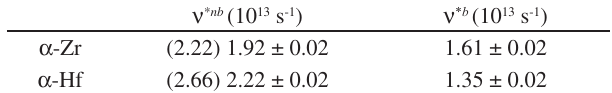
Table 4. Vacancy migration frequency obtained from the Arrhenius plots of both the mean square displacement (in parenthesis) and the jump frequency.